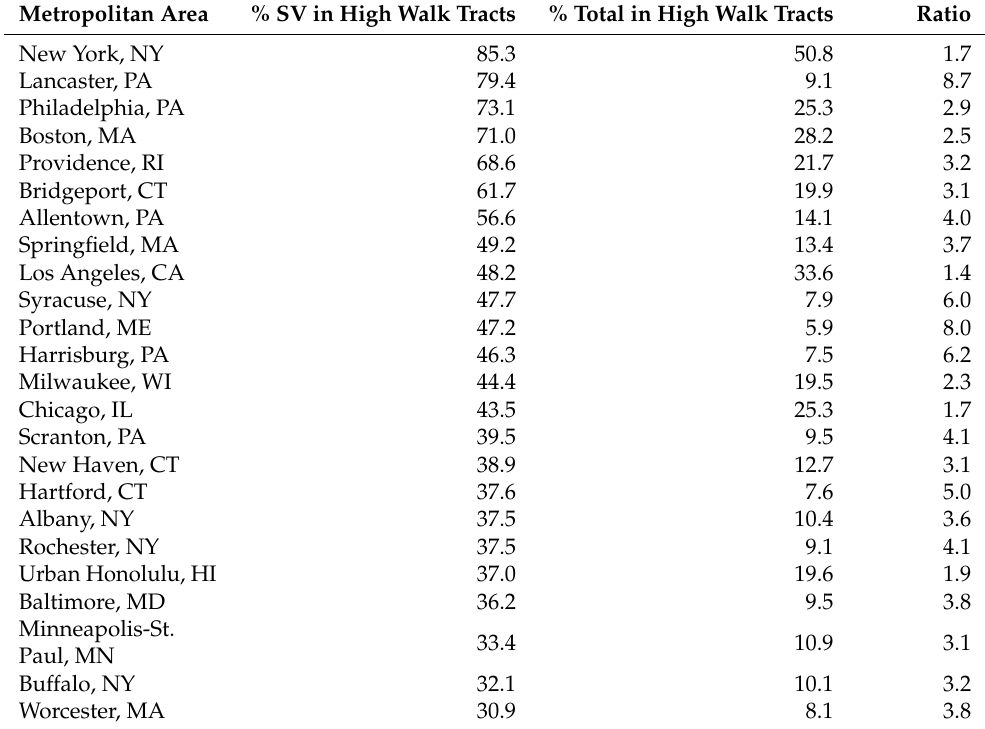
Table A1. Metropolitan areas ranked by proportion of urban population in high-SV census tracts also living in highly walkable (walk score ≥ 70)